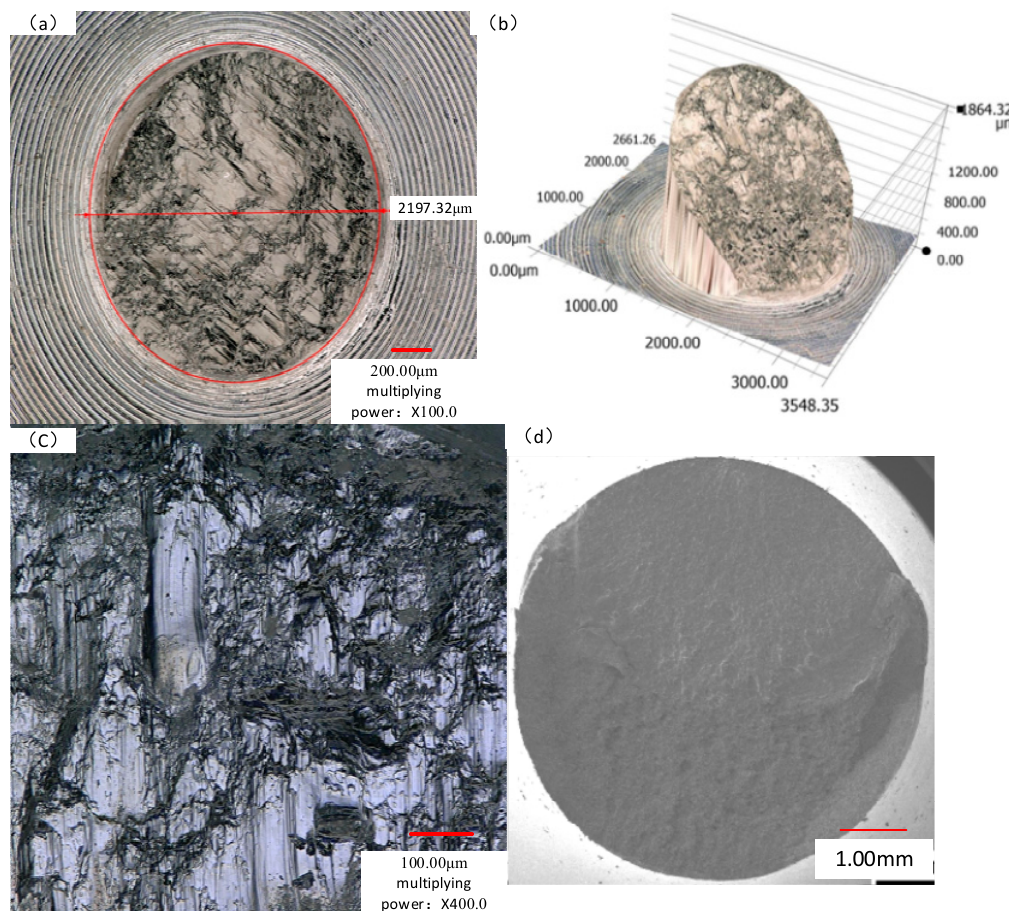
Figure 12. Final fracture area macro map: ( a ) radial microscopic observation; ( b ) microscopic size distribution around a plastic fracture; ( c ) macroscopic map of the final fault zone; ( d ) macroscopic fracture surface.